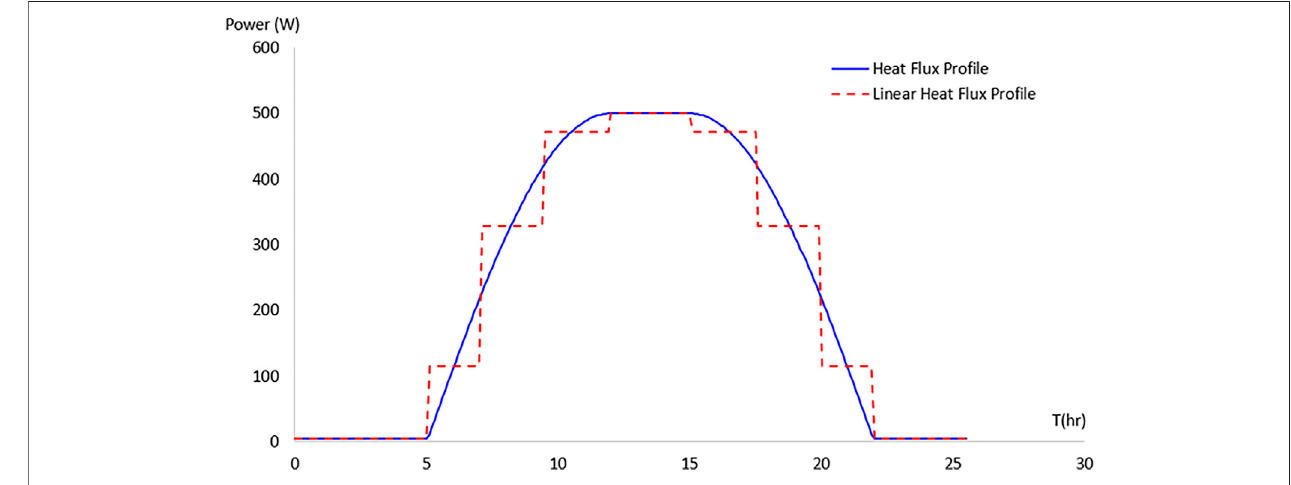
FIGURE 8 | Linearization of periodic external heat fl